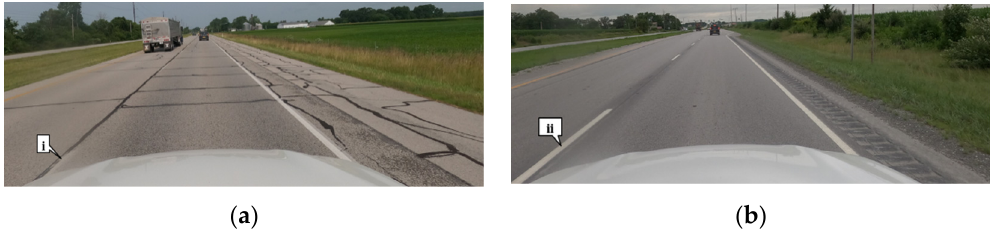
Figure 10. Qualitative comparison of US-52 and US-41: ( a ) US-52 pavement containing crack sealant on roadway surface and ( b ) US-41 pavement without crack sealant on roadway surface.